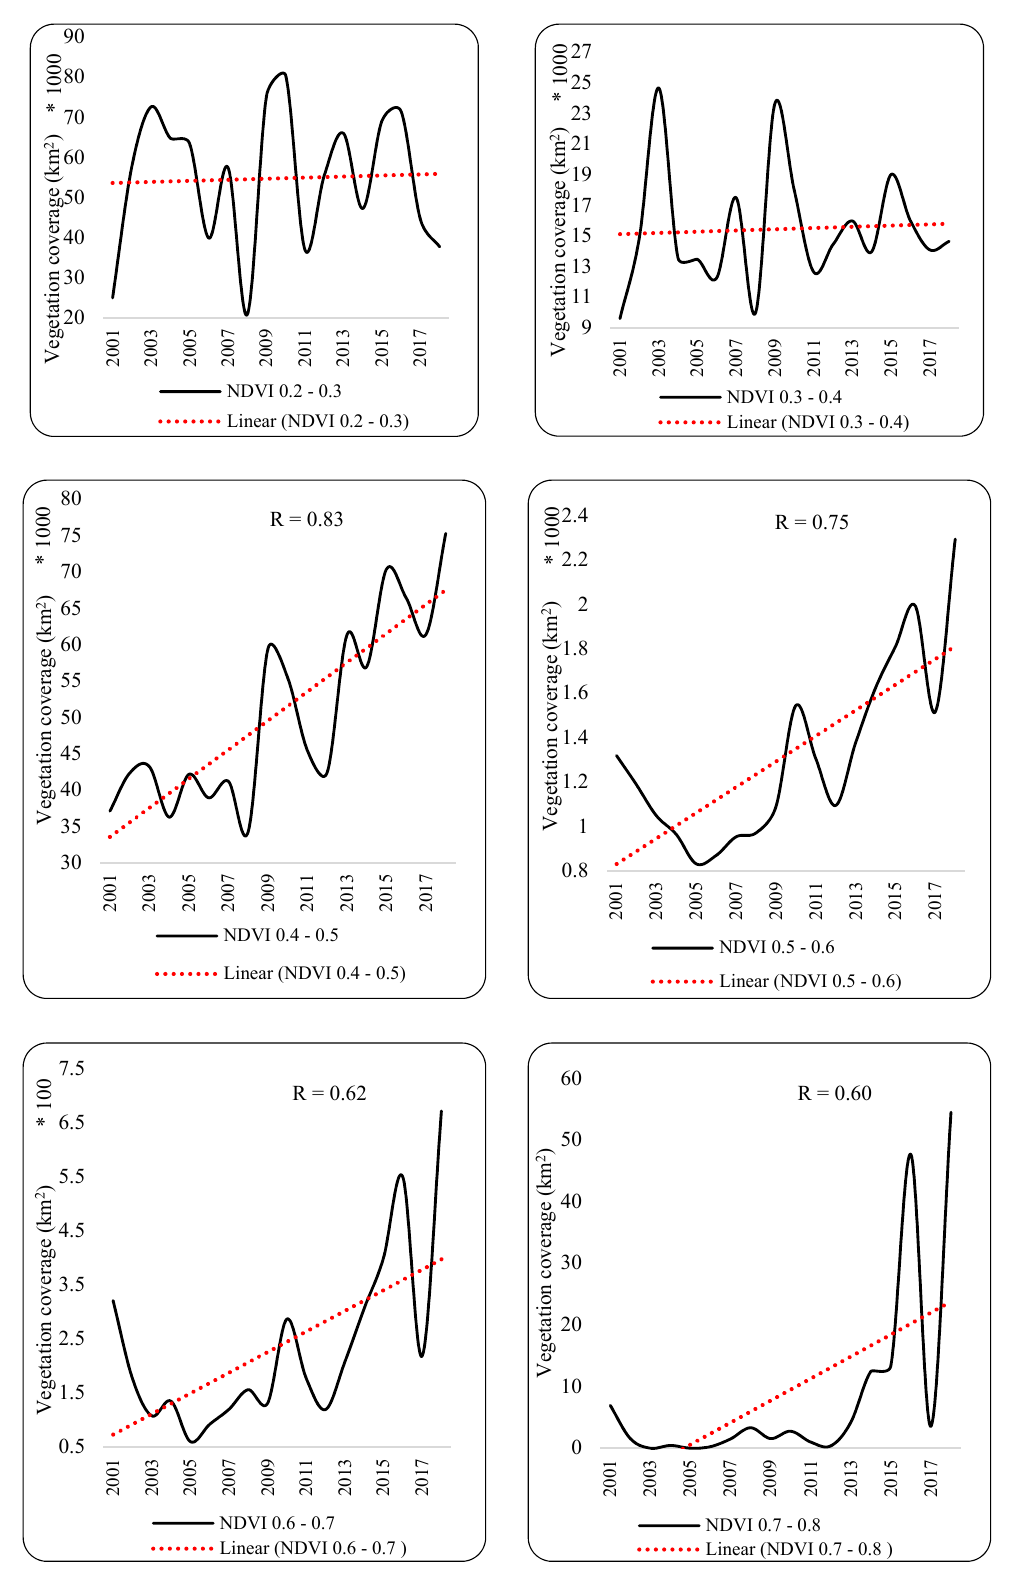
Figure 4. Time series of different categories of NDVI for the study area between 2001 and 2018 (significance level at p = 0.05).